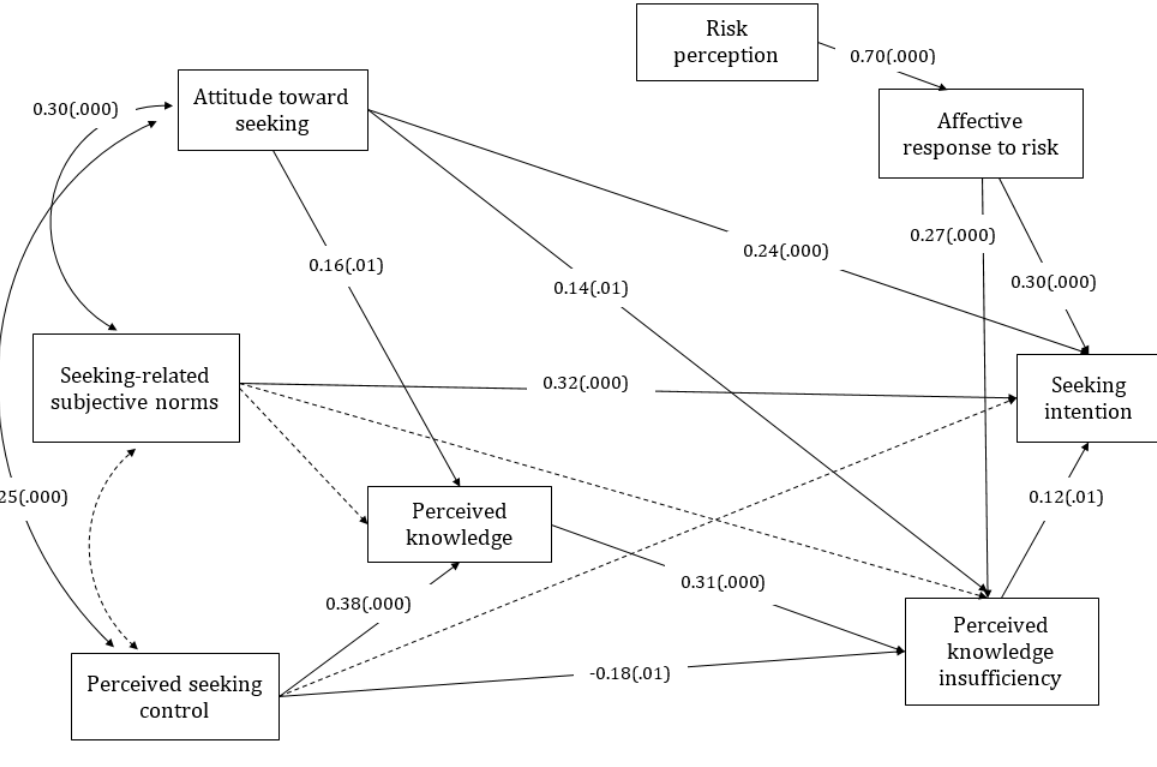
Figure 1. The planned risk information seeking model of the Chinese sample. Dashed lines denote hypothesized nonsignificant paths. The model includes effects of control variables, which are not displayed. (.000) represents significant path coefficients at the .001 level and (.01), at the .05